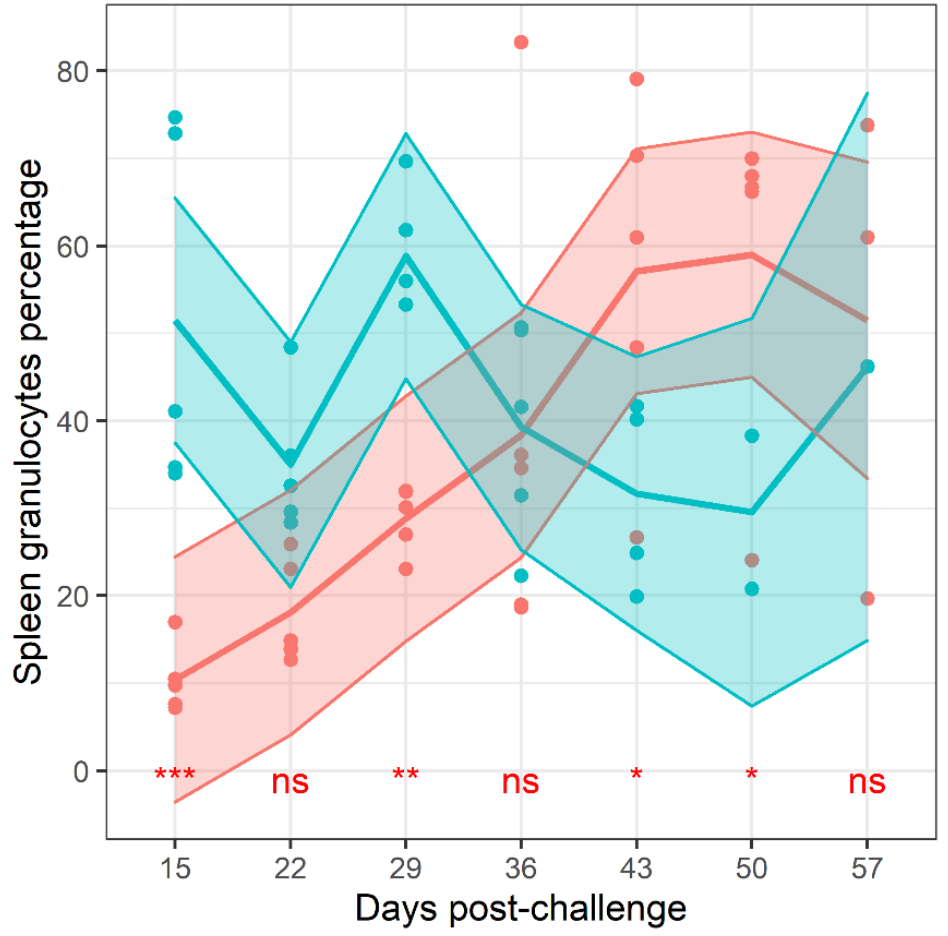
Figure 7. The percentage of granulocytes in the spleen following treatment with antibiotics. Flow cytometry was used to determine the proportion of different immune cell types and markers in the lung, plasma and spleen tissues over time. Red–mice treated with finafloxacin, blue–mice treated with co-trimoxazole, grey–indicates overlapping data from both antibiotics. Across the bottom of the plot are markers to denote the likelihood of the difference between treatment groups occurring randomly: ns = no significance, * 𝑝 < 0.05 , ** 𝑝 < 0.01 and *** 𝑝 < 0.001 .